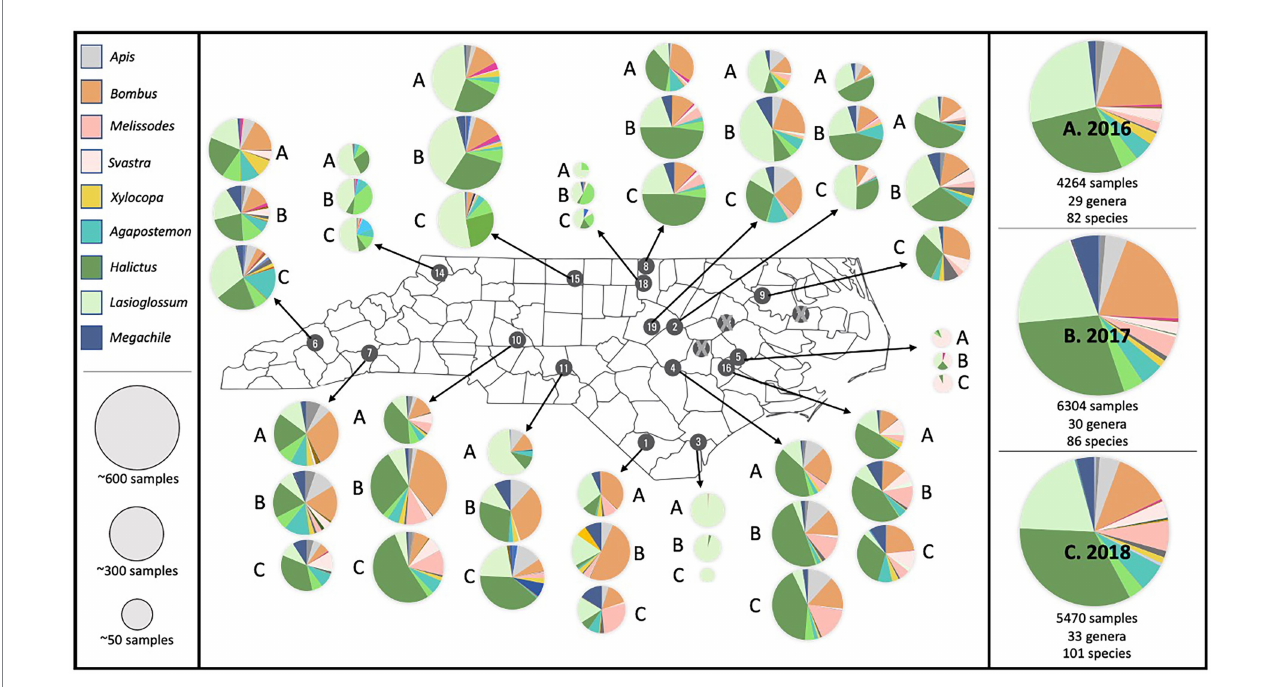
FIGURE 2 Map of the bee abundance and genus richness results for each station across all 3 years. Pie charts represent relative abundance collected at each station and display the most commonly occurring genera across each year. The entire dataset for each year is shown along the right-hand side. The top three genera– Halictus (30%), Lasioglossum (22%), and Bombus (17%)–accounted for 69% of all collected samples.